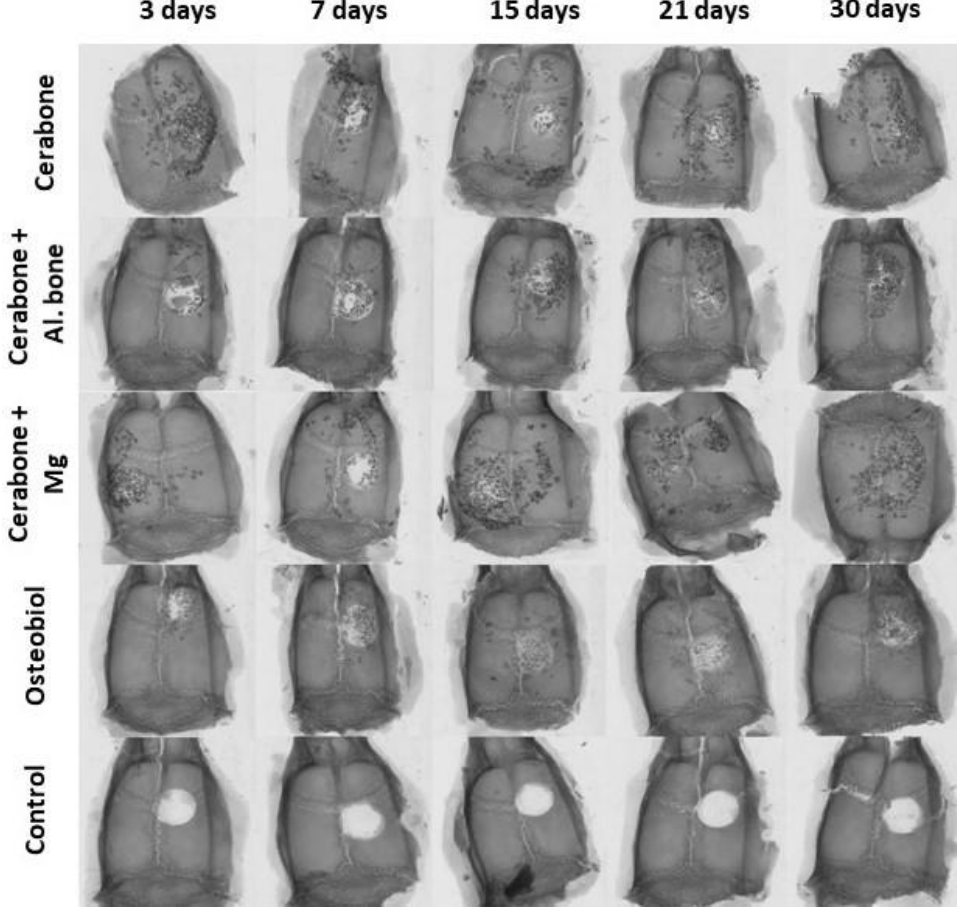
Figure 5. Micro-computed tomography (micro-CT) reconstructed 3D coronal images of 5 mm rat calvarial defects of different xenogeneic biomaterials (in horizontal rows: Cerabone ® ; Cerabone ® + Al. bone; Cerabone ® + Mg; Osteobiol ® ; control) at five different time points (vertical columns: 3rd, 7th, 15th, 21st, and 30th days after implantation), magnification is 2000 × 2000 px.